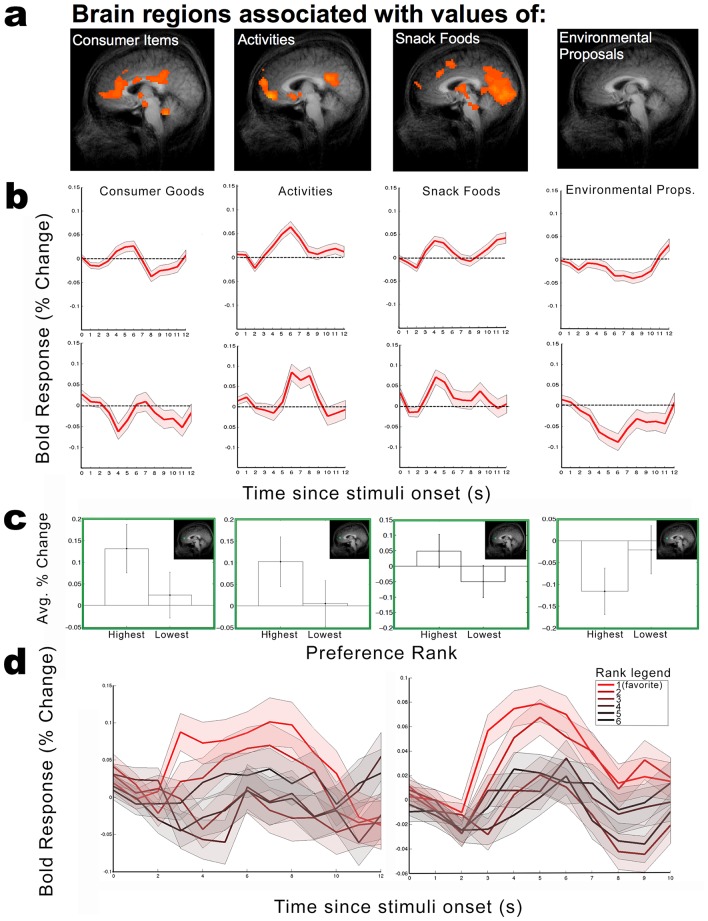
(a) Statistical parameter maps revealing regions associated with subjective value of different categories of goods (p < 0.05, uncorrected). (b) Average time course following the onset of each trial type for spherical ROIs centered on the ventral striatum (top) and vmPFC (bottom). (c) Average time course averaged according to good rank from the vmPFC (left) and ventral striatum (right). (d) Differential activity within vmPFC region of interest (inset) for highest and lowest ranked goods (error bars indicates ± s.e. of the mean). Inset: spherical vmPFC ROI used to compute average change BOLD activity between time points 5–8 after stimuli onset.